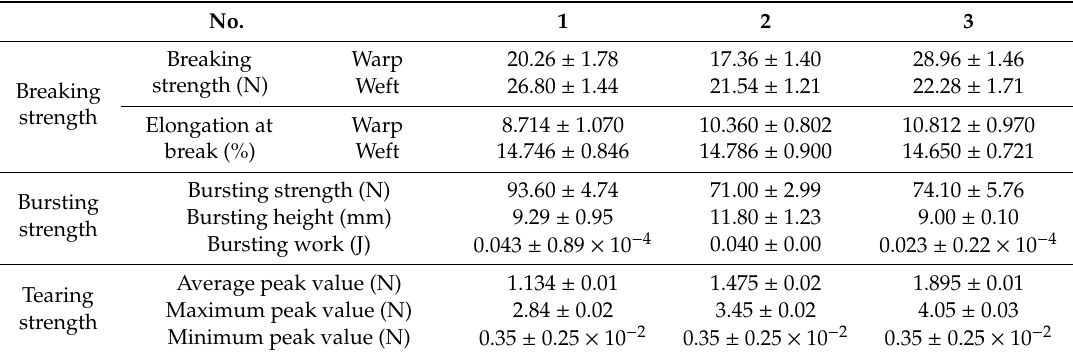
Table 4. Mechanical properties of three kinds of